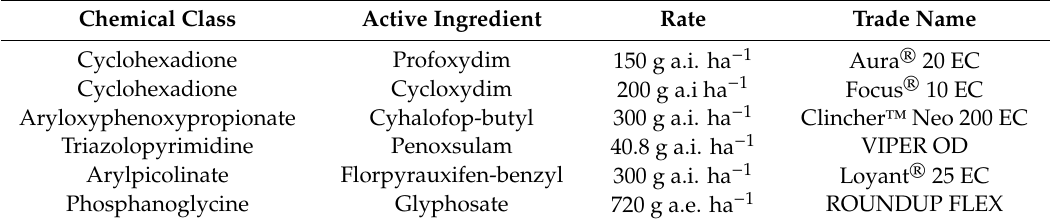
Table 2. Application rates for the herbicides applied in Experiment